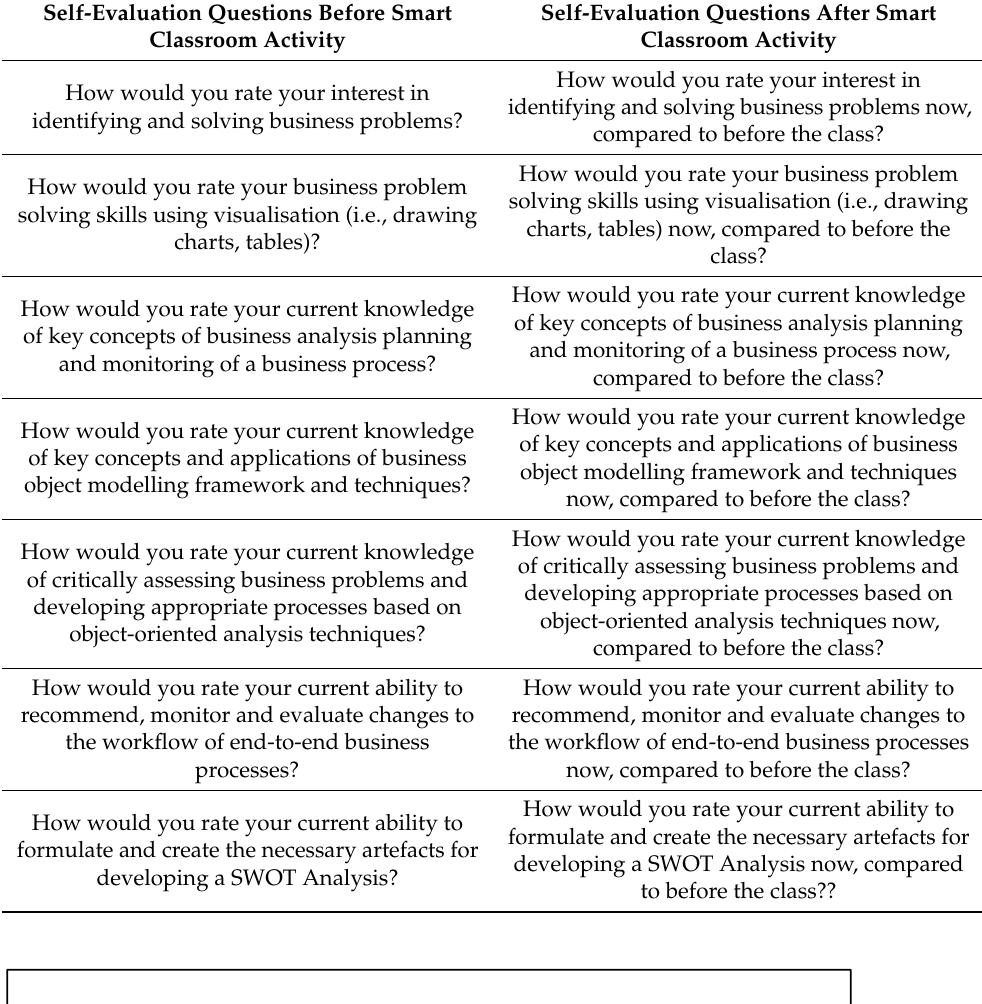
Table 1. Sample student self-evaluation questionnaire.